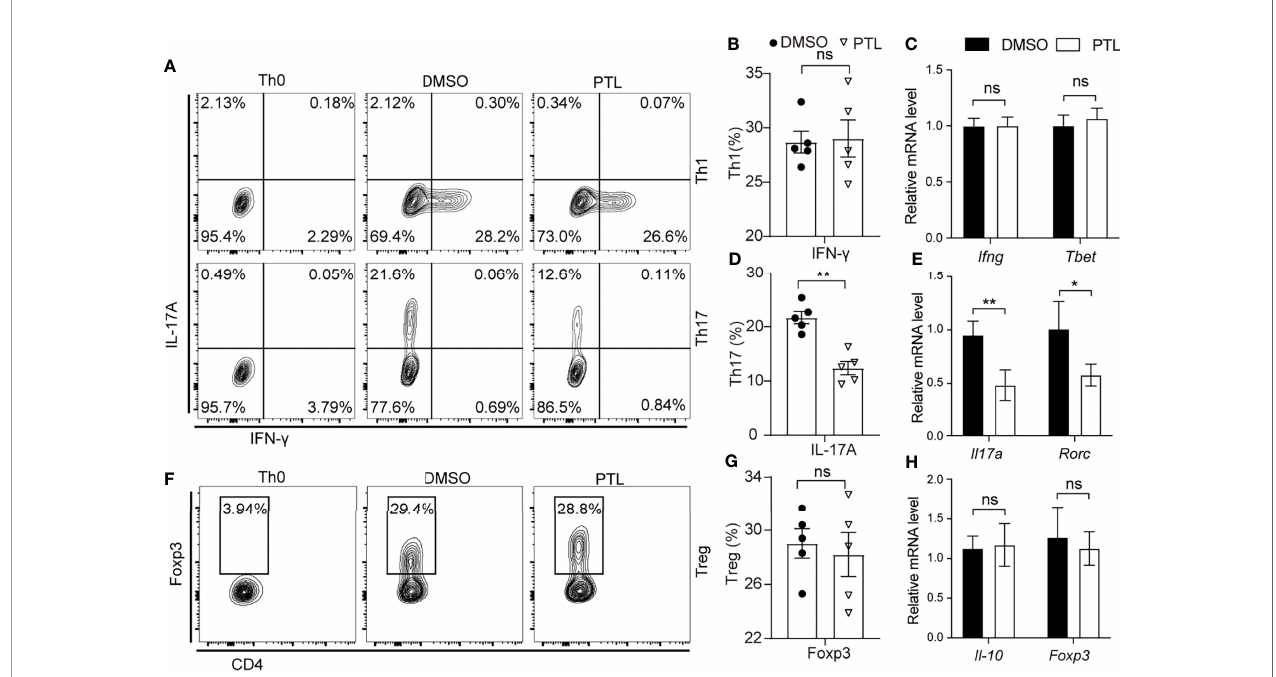
FIGURE 5 | PTL suppressed Th17 differentiation. Naïve CD4 + T cells were sorted from spleen and lymph node and polarized with Th0, Th1, Th17, and Treg condition with or without PTL (3 m M) treatment for 4 days. (A) Flow cytometry was performed to detect the percentage of Th0, Th1, and Th17 of the DMSO group and PTL group. Statistical analysis of (B) Th1 and (D) Th17 in the PLT group and DMSO group. (F) Flow cytometry was performed to detect the percentage of Tregs in the DMSO group and PTL group. (G) Statistical analysis of Treg cell percentage in the DMSO and PTL-treated group. (C, E, H) The mRNA expression of Th1-, Th17-, and Treg-related cytokines and transcription factors was detected by RT-PCR after the differentiation. The error bars shown were the mean ± SD. * p < 0.05, ** p < 0.01 using unpaired Student ’ s t -test. ns means “ not signi fi cant ”